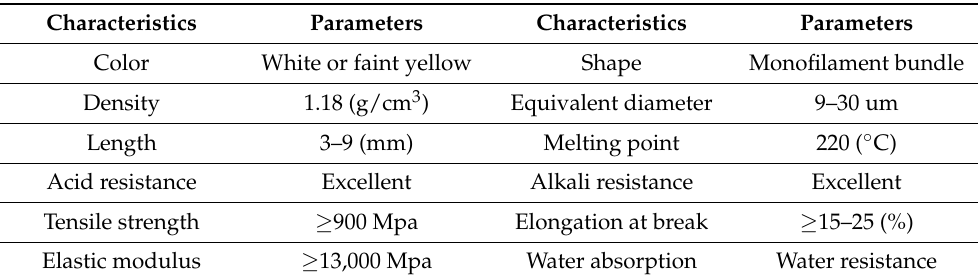
Table 4. Main performance parameters of polypropylene fiber.